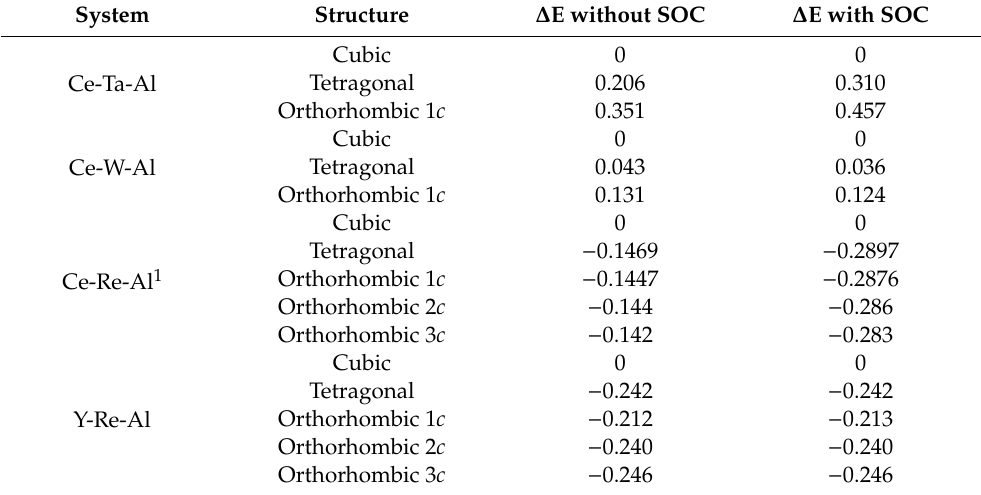
Table 3. Energy di ff erences, ∆ E(Ryd), with respect to the cubic structure.